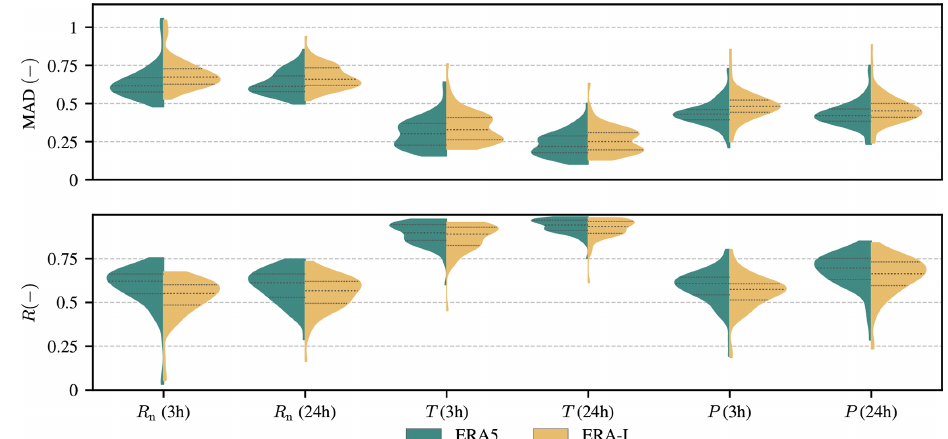
Figure A3. Violin plots of temporal validation statistics of the surface net radiation ( R n ), 2m air temperature ( T ), and precipitation rate ( P ) from ERA5 (green) and ERA-I (yellow). Statistics are calculated against in situ eddy-covariance measurements at both 3-hourly and daily temporal resolutions. Violin plots represent the distribution of the individual validation statistics with indication of the median and interquartile range and are calculated using a kernel density estimation approach. Statistics include the MAD (anomaly in situ time series from 83 sites as reference) and R (anomaly in situ time series from 83 sites as reference).